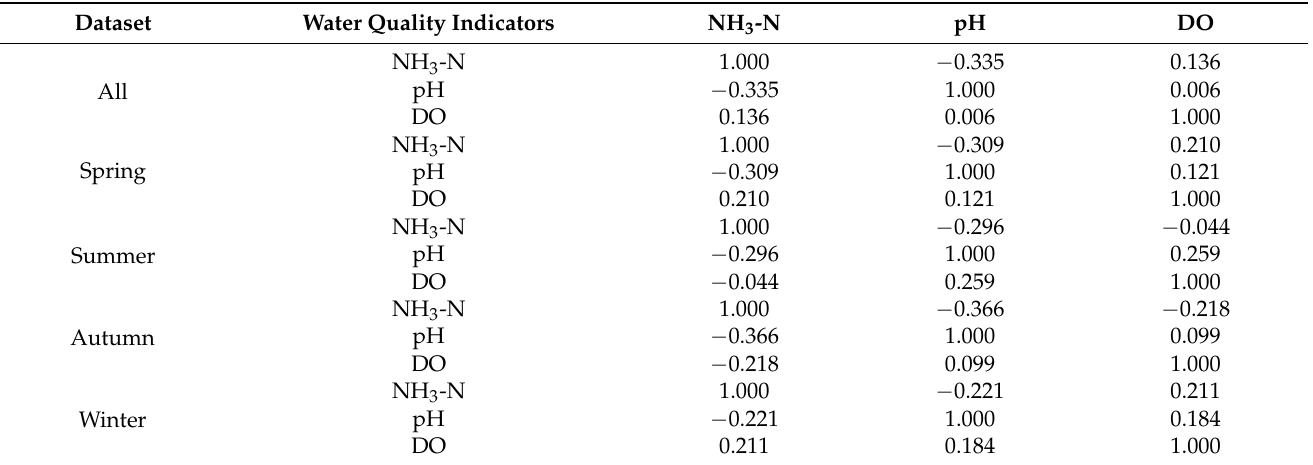
Table 2. Results of correlation analysis of water quality